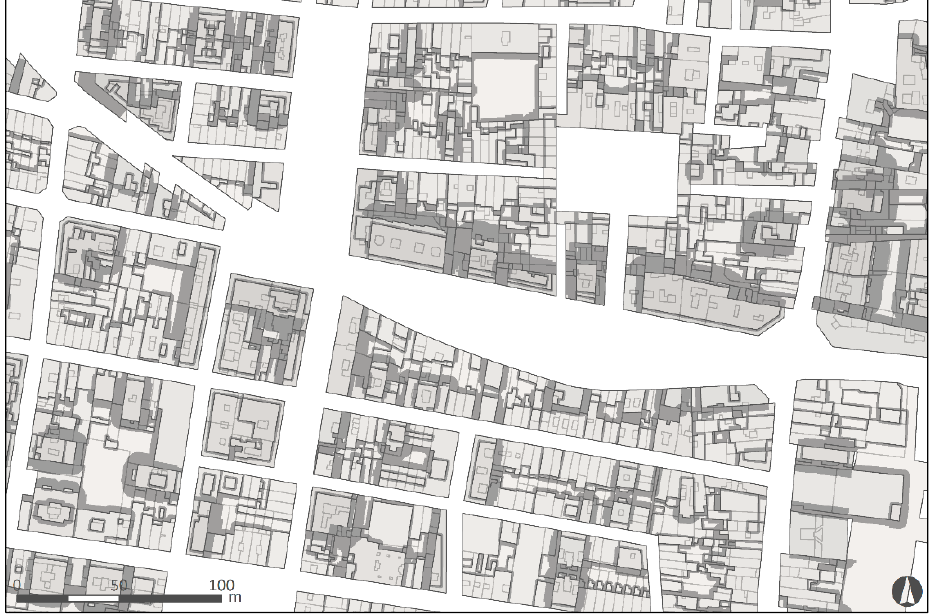
Figure 18. Occlusion of higher volumes onto neighboring lower